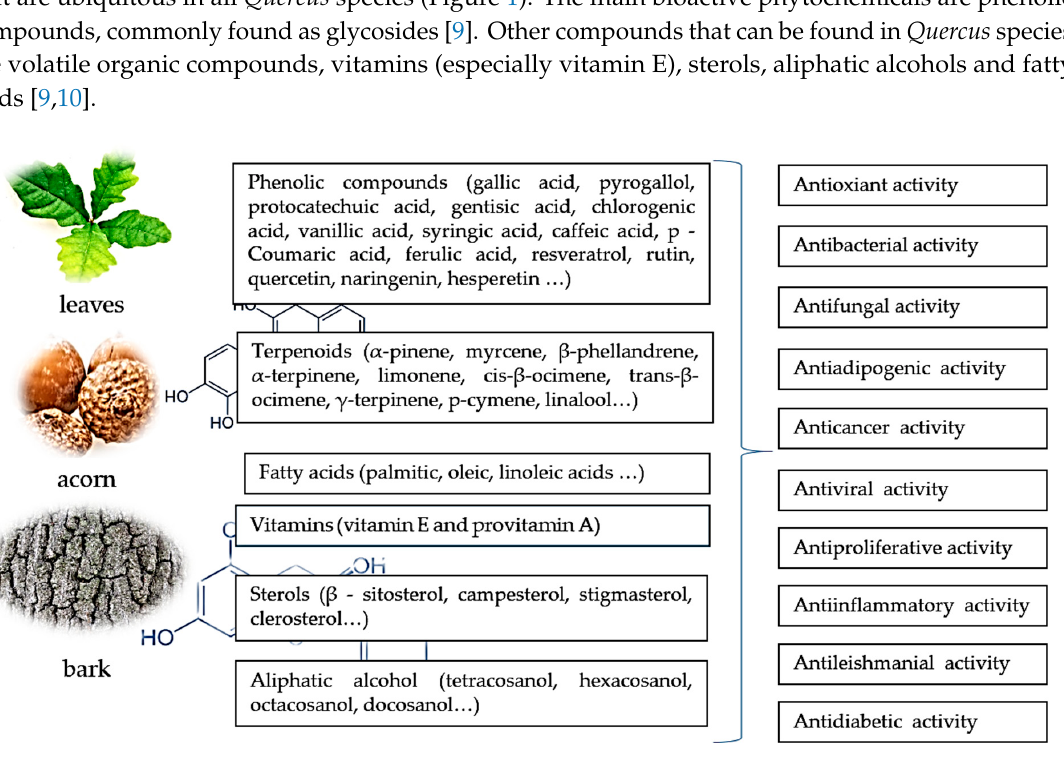
Figure 1. The main phytochemical compounds and biological activities of Quercus sp.